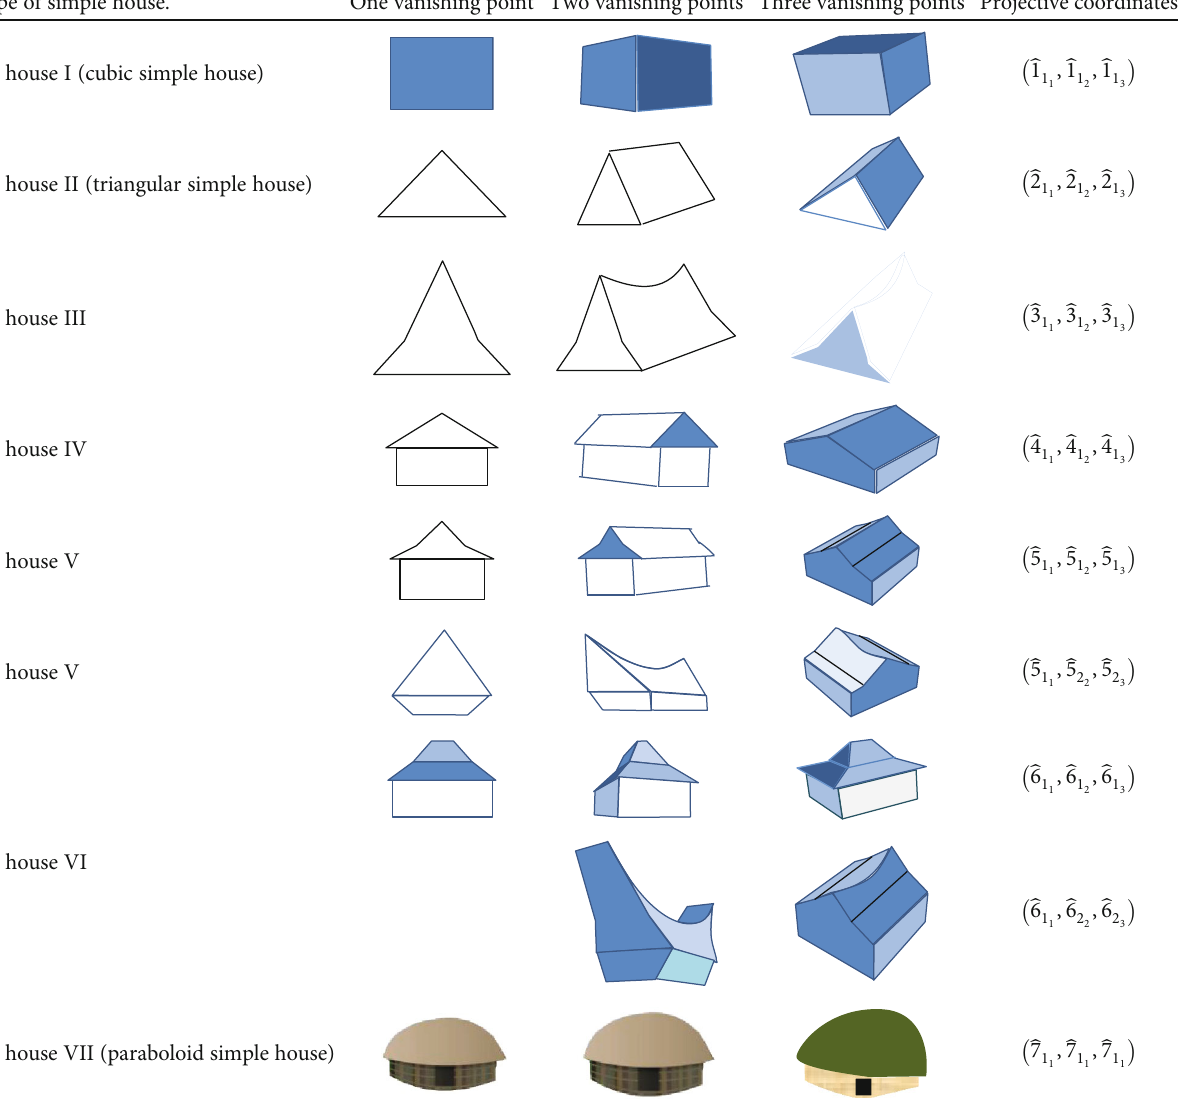
Table 1: Summary of simple houses ’ projective coordinates. The type of simple